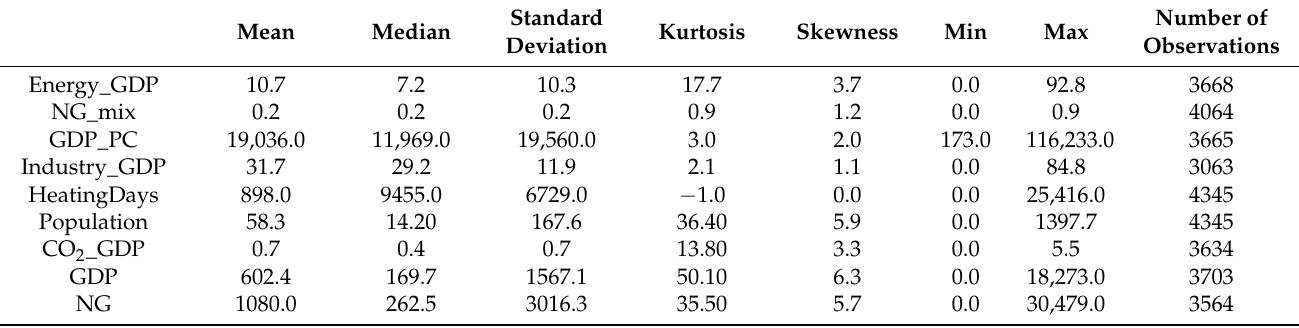
Table 2. Basic descriptive statistics of